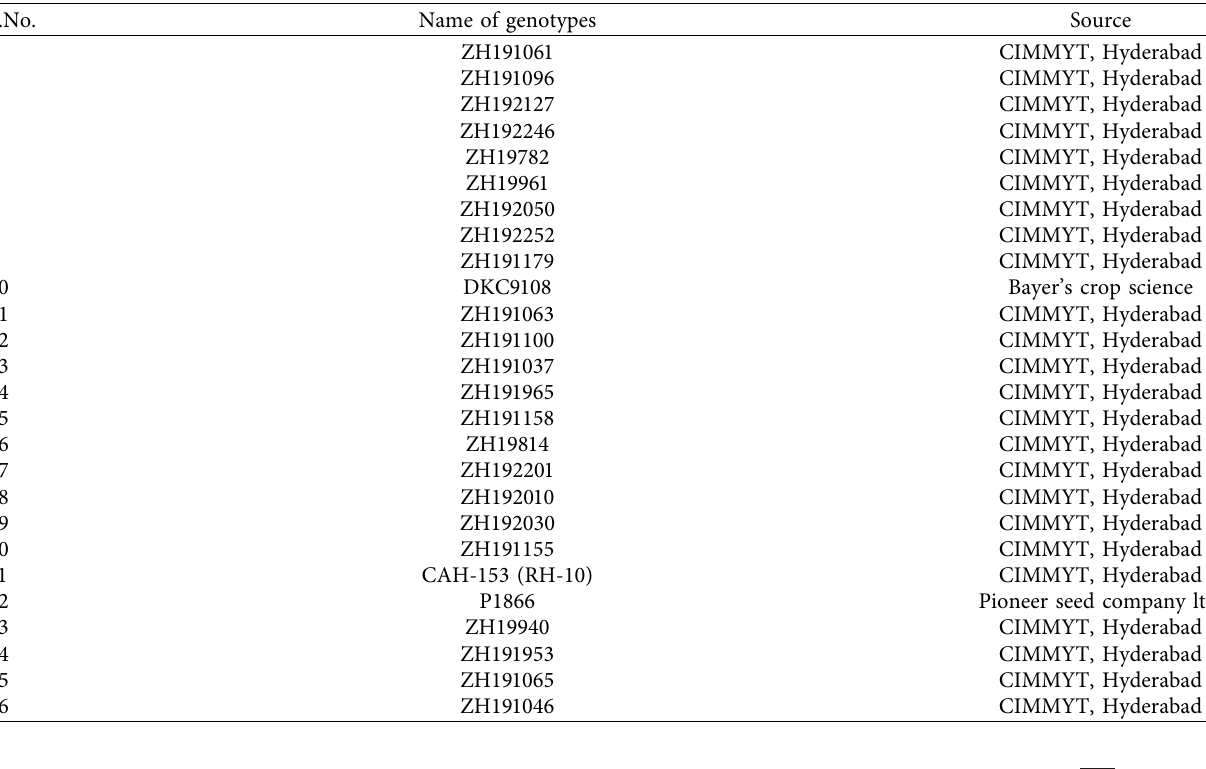
Table 1: List of the genotype varieties used in for experimental study.